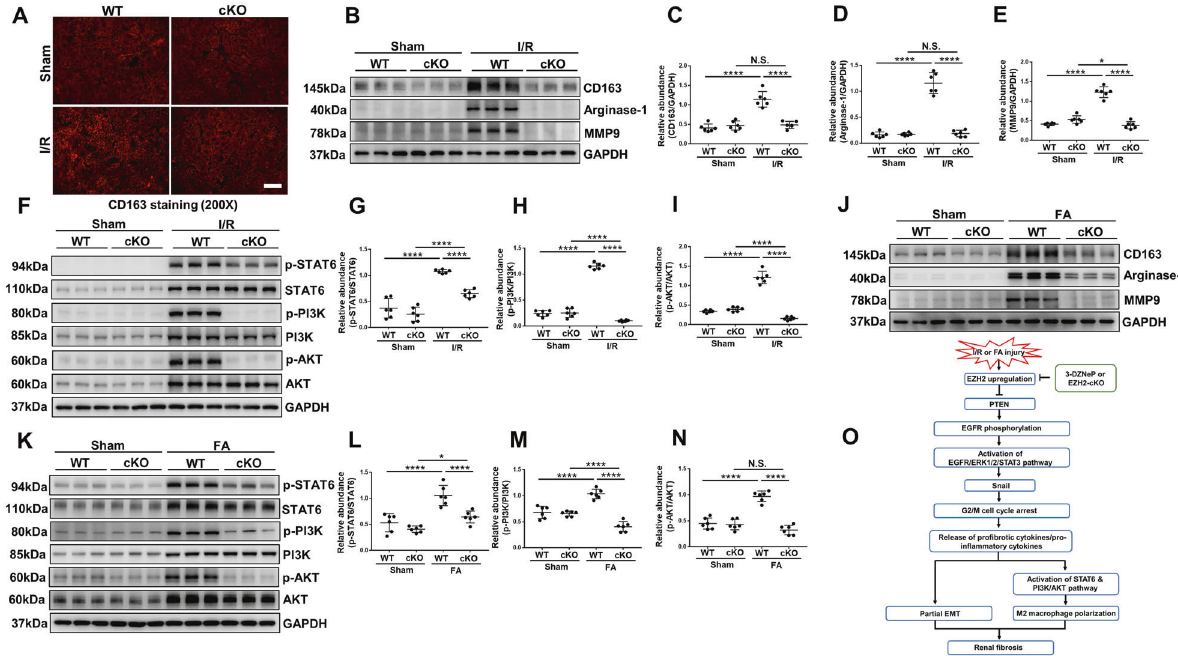
Fig. 8 EZH2 conditional knockout inhibits M2 macrophage polarization through STAT6 and PI3K/AKT pathways in I/R or FA induced AKI- to-CKD transition mice models. A Photomicrographs showed the immuno fl uorescent staining of CD163 in different groups. B Kidney tissue lysates from I/R mice were prepared and subjected to immunoblotting analysis with antibodies against CD163, Arginase-1, MMP9, and GAPDH. C – E Expression levels of CD163, Arginase-1, MMP9 in different groups were quanti fi ed by densitometry and normalized with GAPDH. F Kidney tissue lysates from I/R mice were prepared and subjected to immunoblotting analysis with antibodies against p-STAT6, STAT6, p-PI3K, PI3K, p-AKT, AKT, and GAPDH. G – I Expression levels of p-STAT6, p-PI3K, and p-AKT were quanti fi ed by densitometry and normalized with STAT6, PI3K, and AKT. J Kidney tissue lysates from FA mice were prepared and subjected to immunoblotting analysis with antibodies against CD163, Arginase-1, MMP9, and GAPDH. K Kidney tissue lysates from FA mice were prepared and subjected to immunoblotting analysis with antibodies against p-STAT6, STAT6, p-PI3K, PI3K, p-AKT, AKT, and GAPDH. L – N Expression levels of p-STAT6, p-PI3K, and p-AKT were quanti fi ed by densitometry and normalized with STAT6, PI3K, and AKT. O The role and mechanisms of EZH2 in AKI-to-CKD transition. Data were expressed as means ± SEM. * P < 0.05; ** P < 0.01; *** P < 0.001; **** P < 0.0001. N.S., statistically not signi fi cant, with the comparisons labeled. All scale bars = 50 μ